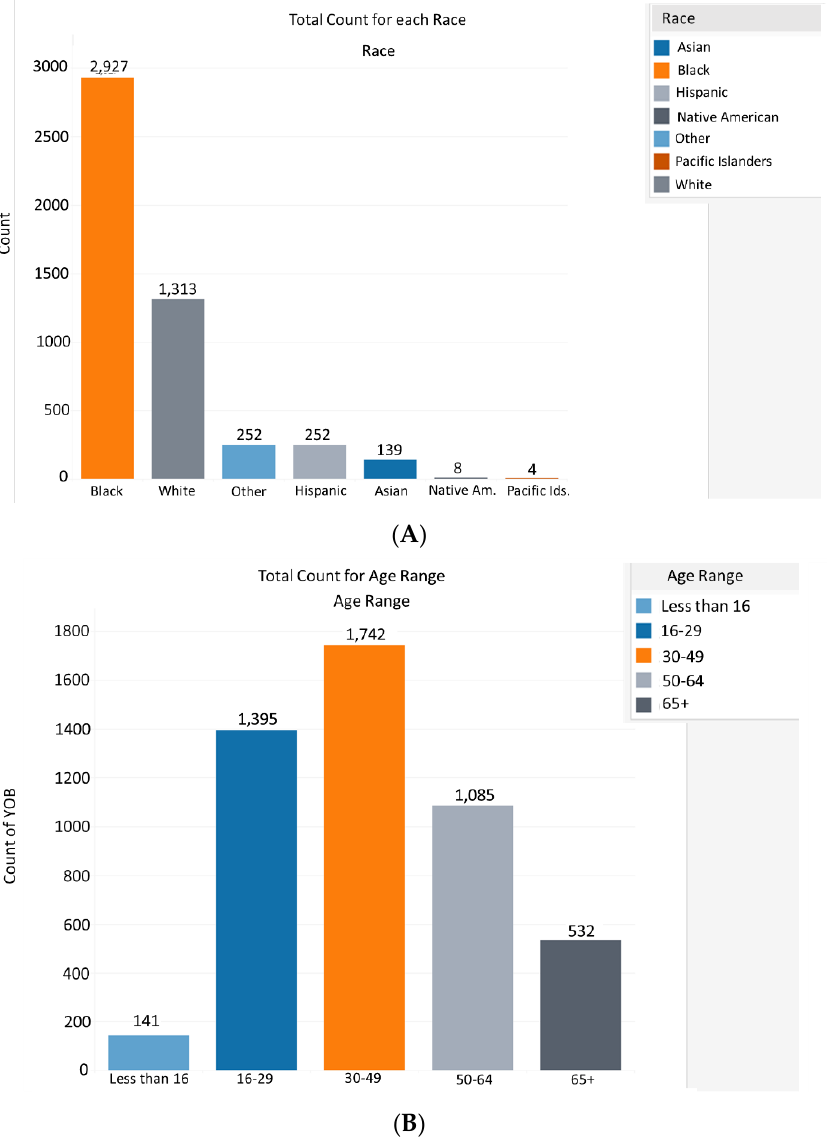
Figure 5. Total number of vaccinations provided by the Meharry Medical College-Mobile Vaccination Program by race ( A ) and by age ( B ).